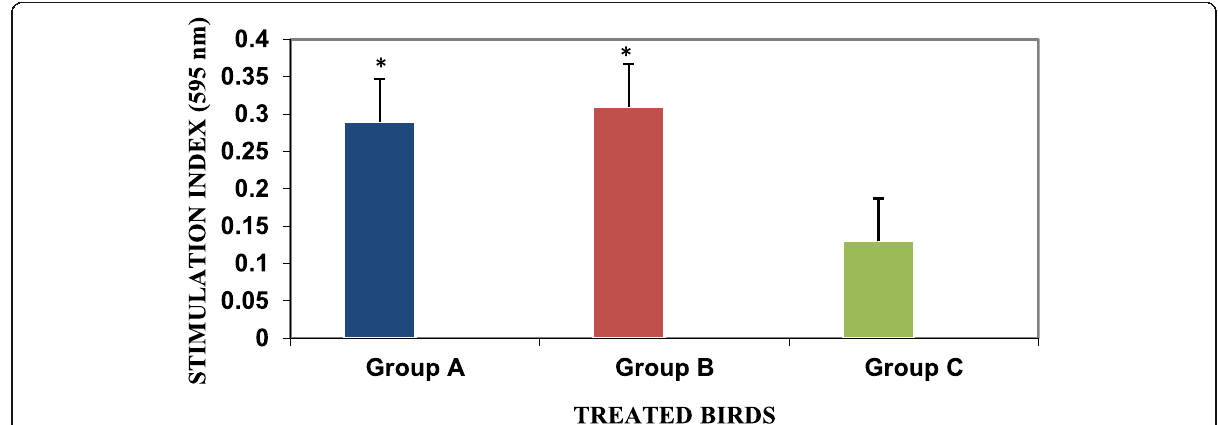
Fig. 5 In vitro lymphoproliferation assay of intestinal intra-epithelial leucocytes (iIEL) of MG-fed and control broiler birds after challenge with ND